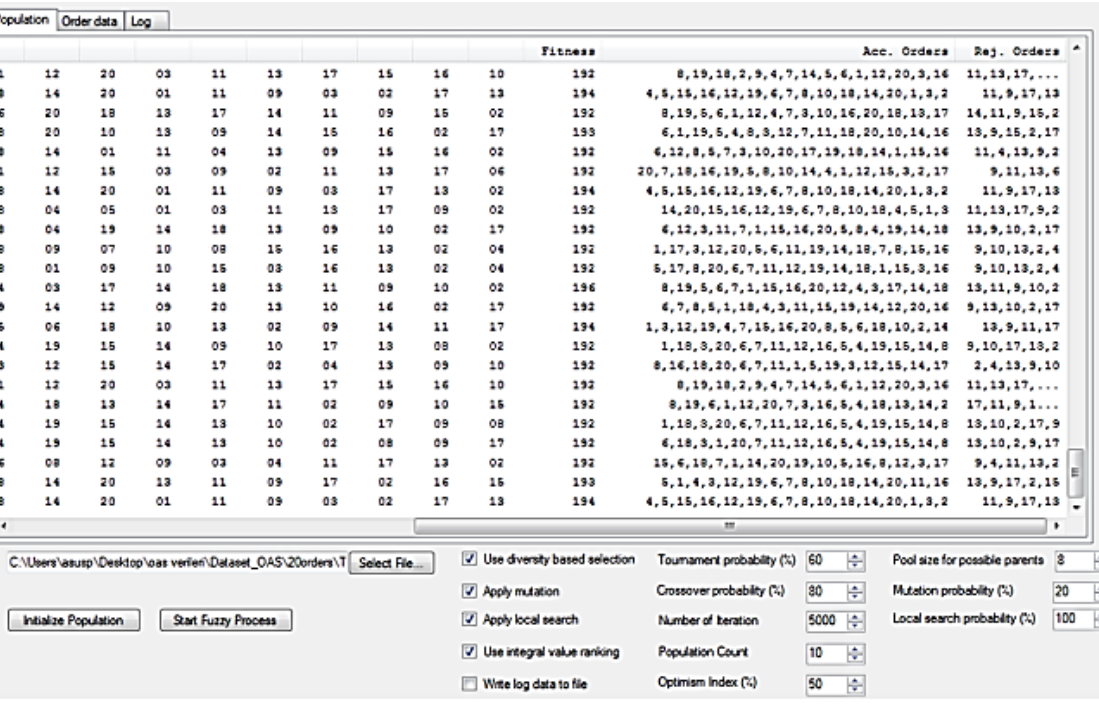
Figure A4. Solution screen with integral value method ( α =0,5) for instance